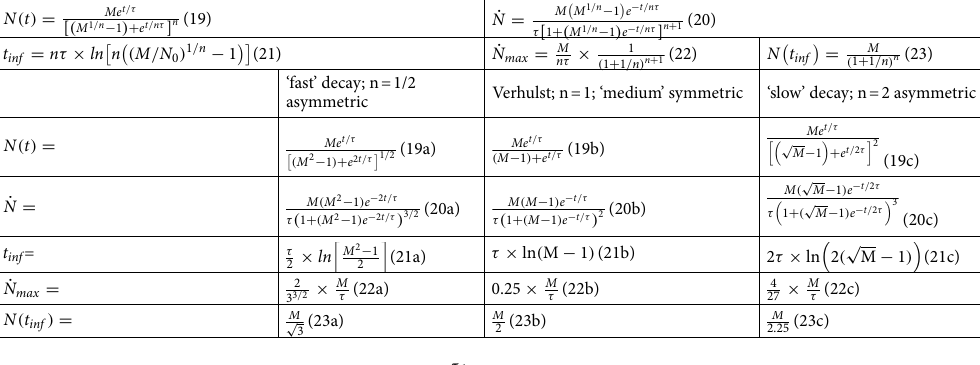
τ decay τ growth with n = ½, 1 and